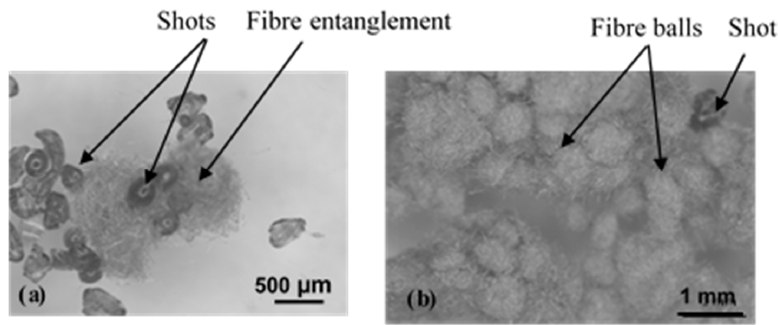
Figure 2. Arrangements of fibres for ( a ) FMFBs and ( b ) FMFS.